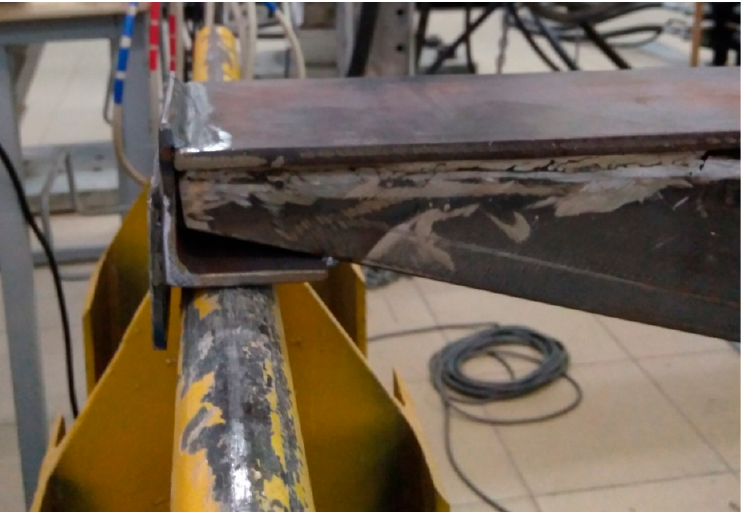
Figure 6. Installing the truss on stationary inventory support.